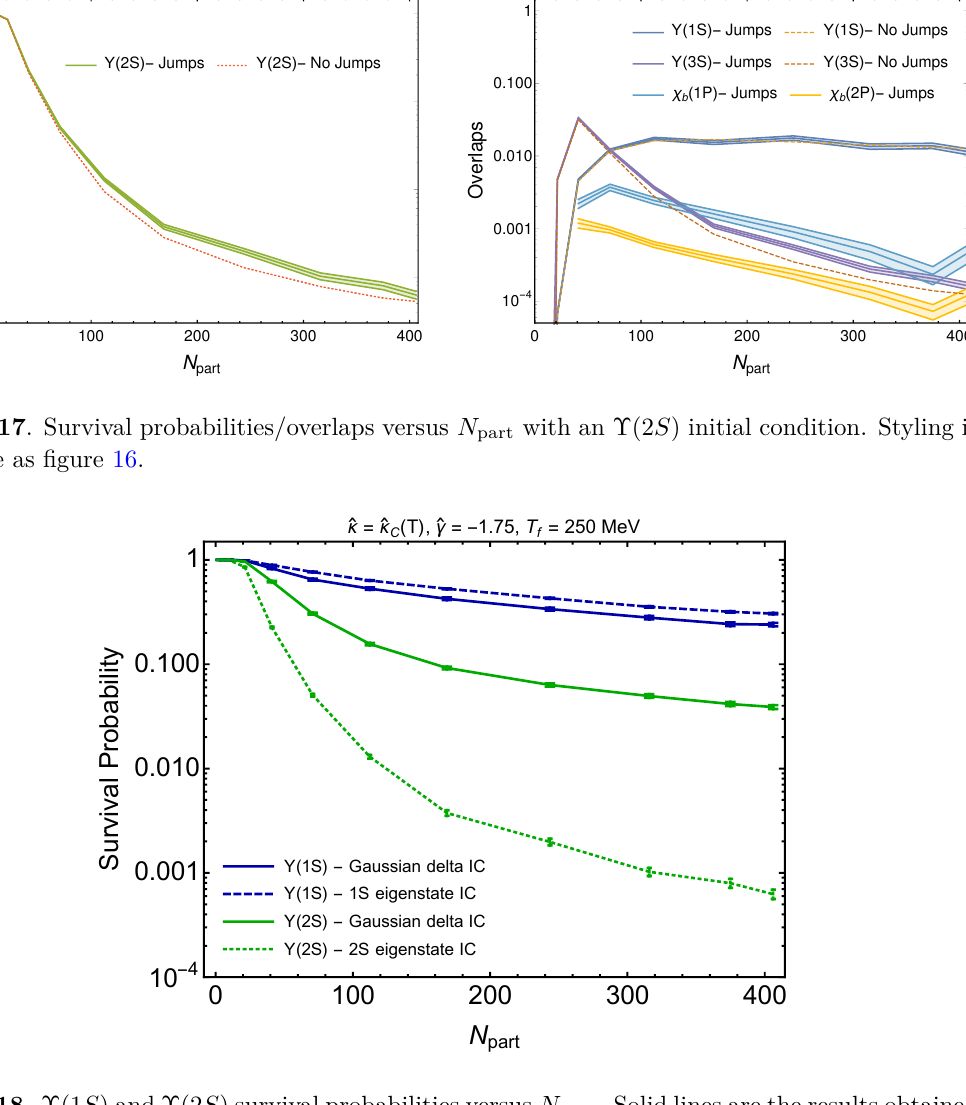
Figure 18 . Υ(1 S ) and Υ(2 S ) survival probabilities versus N part . Solid lines are the results obtained from the singlet S -wave Gaussian delta initial condition (IC) used in the main body of the paper. The dashed and dotted lines are the results obtained from Υ(1 S ) and Υ(2 S ) initial conditions, respectively. In both cases, the effect of jumps is included. The error bars are the statistical errors associated with the average over quantum